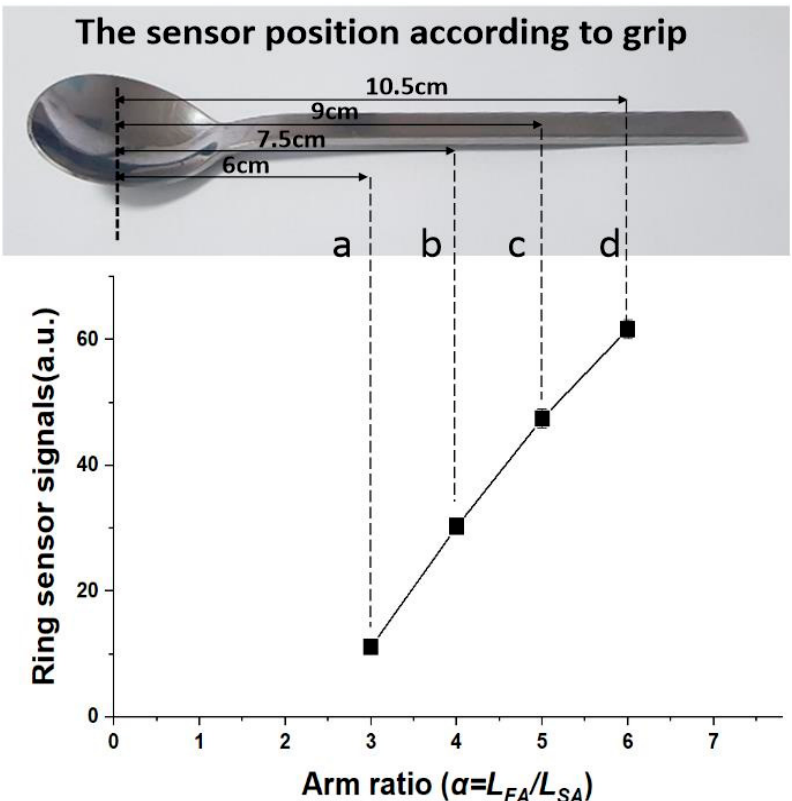
Figure 3. Experimental verification result of the first-class lever mechanism through ring sensor signals according to the gripped position of the spoon ( n = 15). The sensor signal increases in proportion to the arm ratio, where the sensor position is the position of the thumb when holding the spoon and L SA is fixed at 1.5 cm.